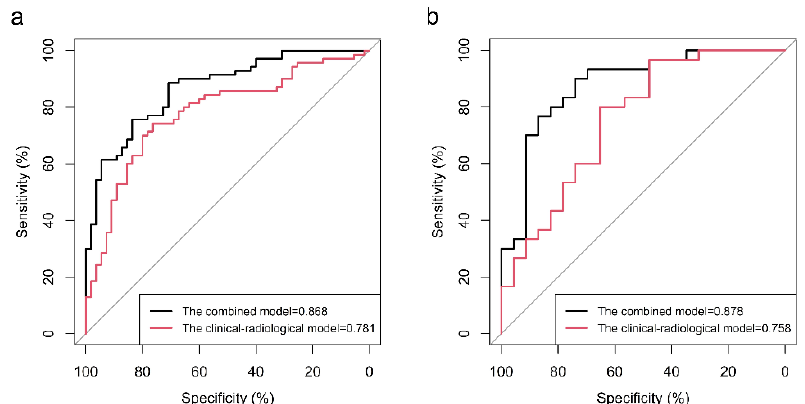
Figure 5. Comparison of the receiver operating characteristic (ROC) curves of the clinical–radiological model and the combined model in the training cohort ( a ) and test cohort ( b ). The predictive performance of the combined model was better than that of the clinical–radiological model in both the training and the test cohort. Abbreviation: ROC, receiver operating characteristic.